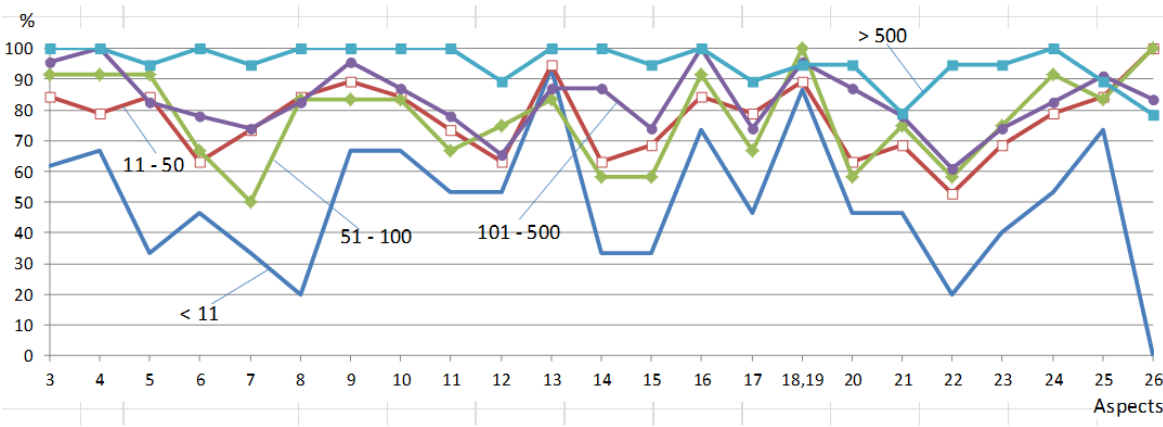
Figure 8. Dependence of % EOls (at v100% i-security performance), by categories according to the number of employees, on aspects 3 –